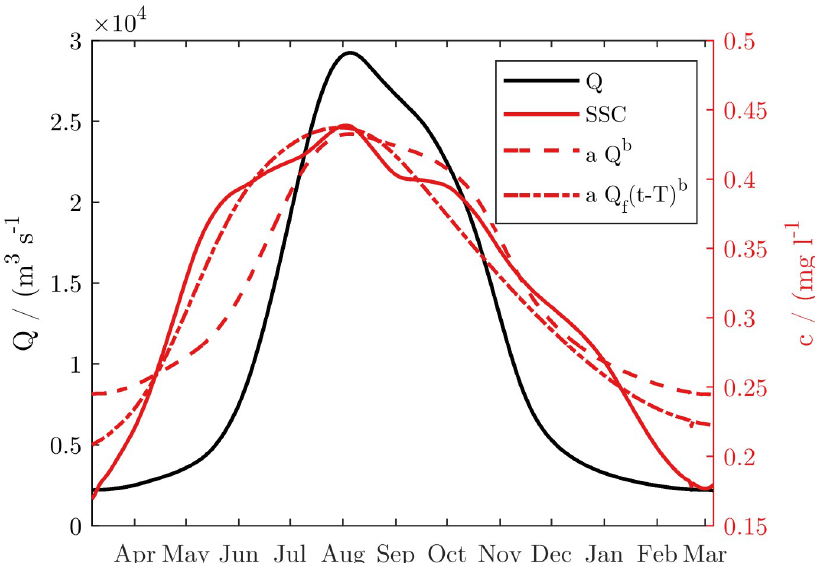
Fig 10. Surface reflectance at the Chindwin confluence for July averaged over the years 2002–2020 (MODIS Terra and Aqua). Higher reflectance of the Chindwin and Lower Ayeyarwady indicate that the bulk of SSC is derived from the Chindwin basin, and not the Upper